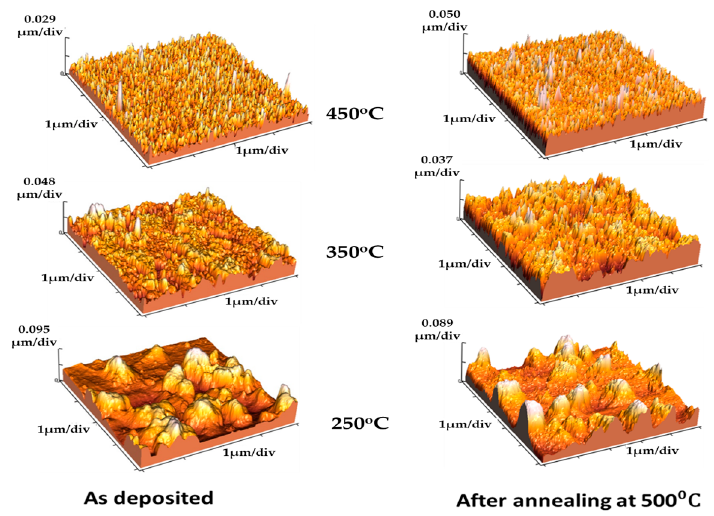
Figure 2. Three-dimensional AFM images of the as-deposited and annealed films. Table 1. Roughness and contact angle for the deposited and annealed samples.